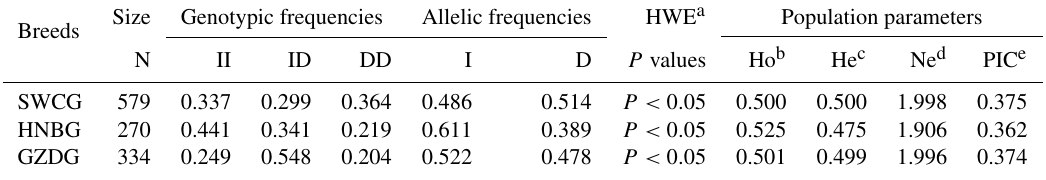
Table 2. Genotypic and allelic frequencies and population indexes for the ATBF1 gene P1-12-bp indel in three Chinese goat breeds. Size Genotypic frequencies Allelic frequencies HWE a Population parameters Breeds N ID HNBG